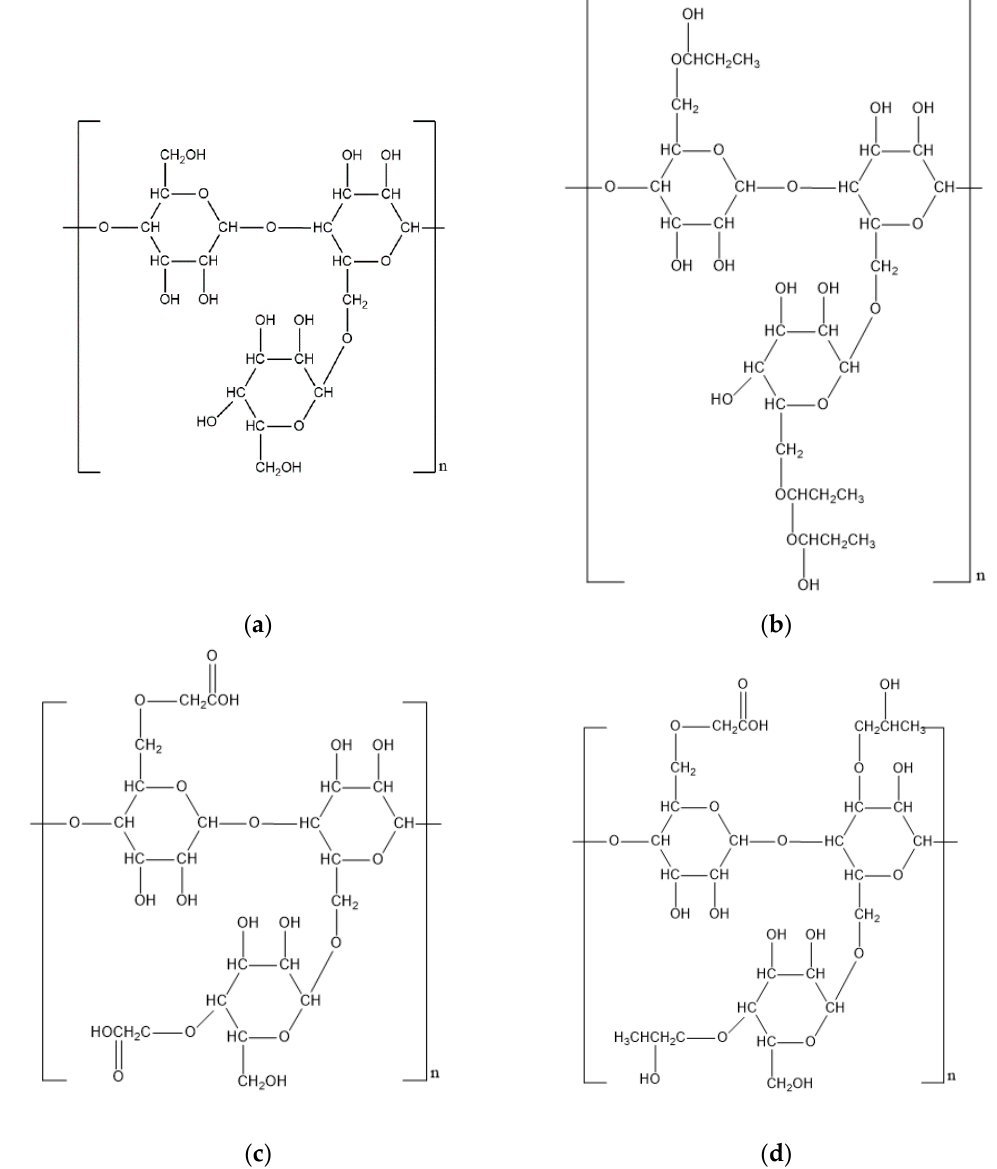
Figure 5. The molecular structure of ( a ) Guar gum; ( b ) Hydroxypropyl Guar; ( c ) Carboxymethyl Guar; ( d ) Carboxymethyl hydroxypropyl Guar.